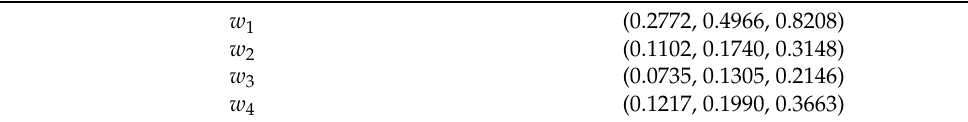
Table 5. Fuzzy values of the first-level criteria